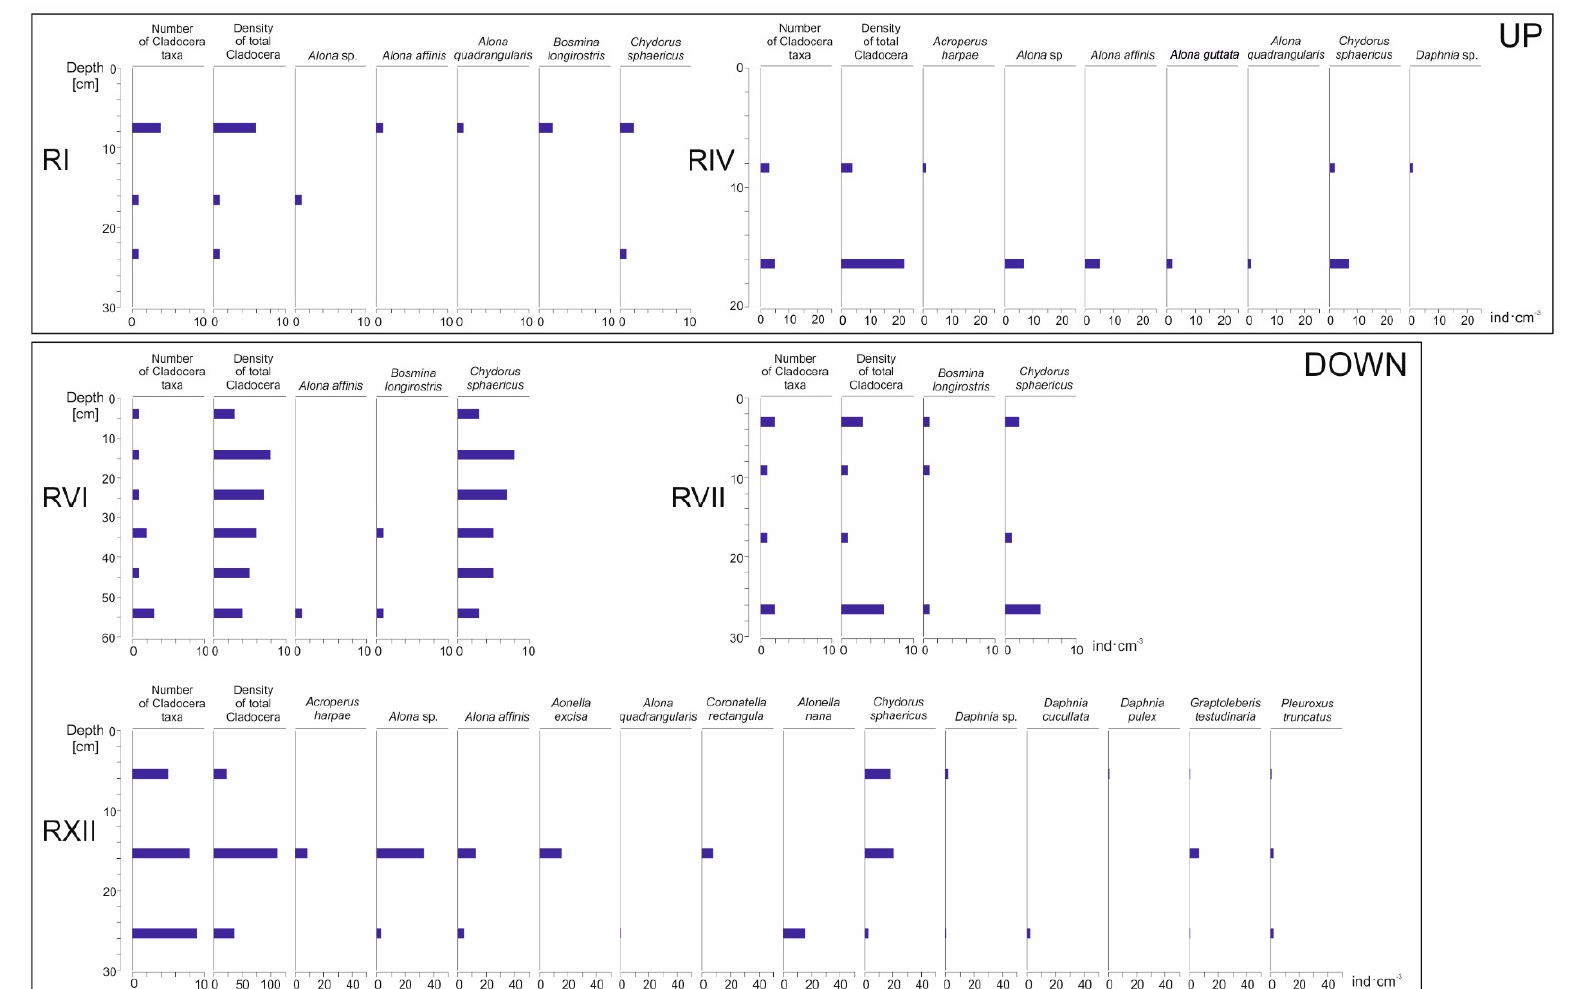
Figure 3. Density of Cladocera taxa in sediment cores (ind. / cm 3 ) from subsidence pond created after mine was closed (UP) and ponds existed during mine exploitation (DOWN).